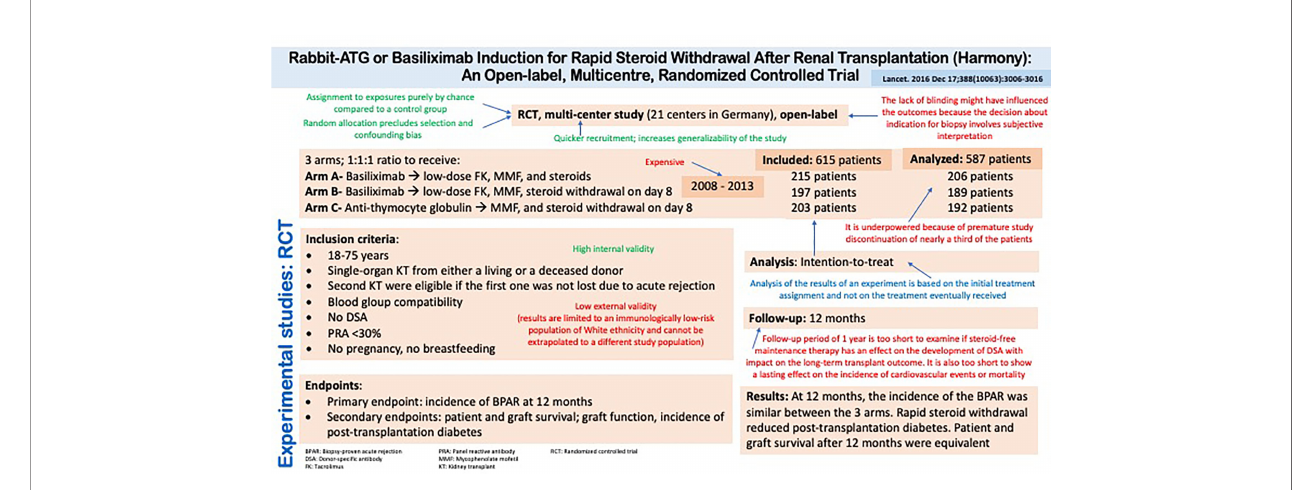
FIGURE 3 | Experimental studies: Randomized Controlled Trial. Rabbit-ATG or Basiliximab Induction for Rapid Steroid Withdrawal After Renal Transplantation (Harmony): An Open-label, Multicentre, Randomized Controlled